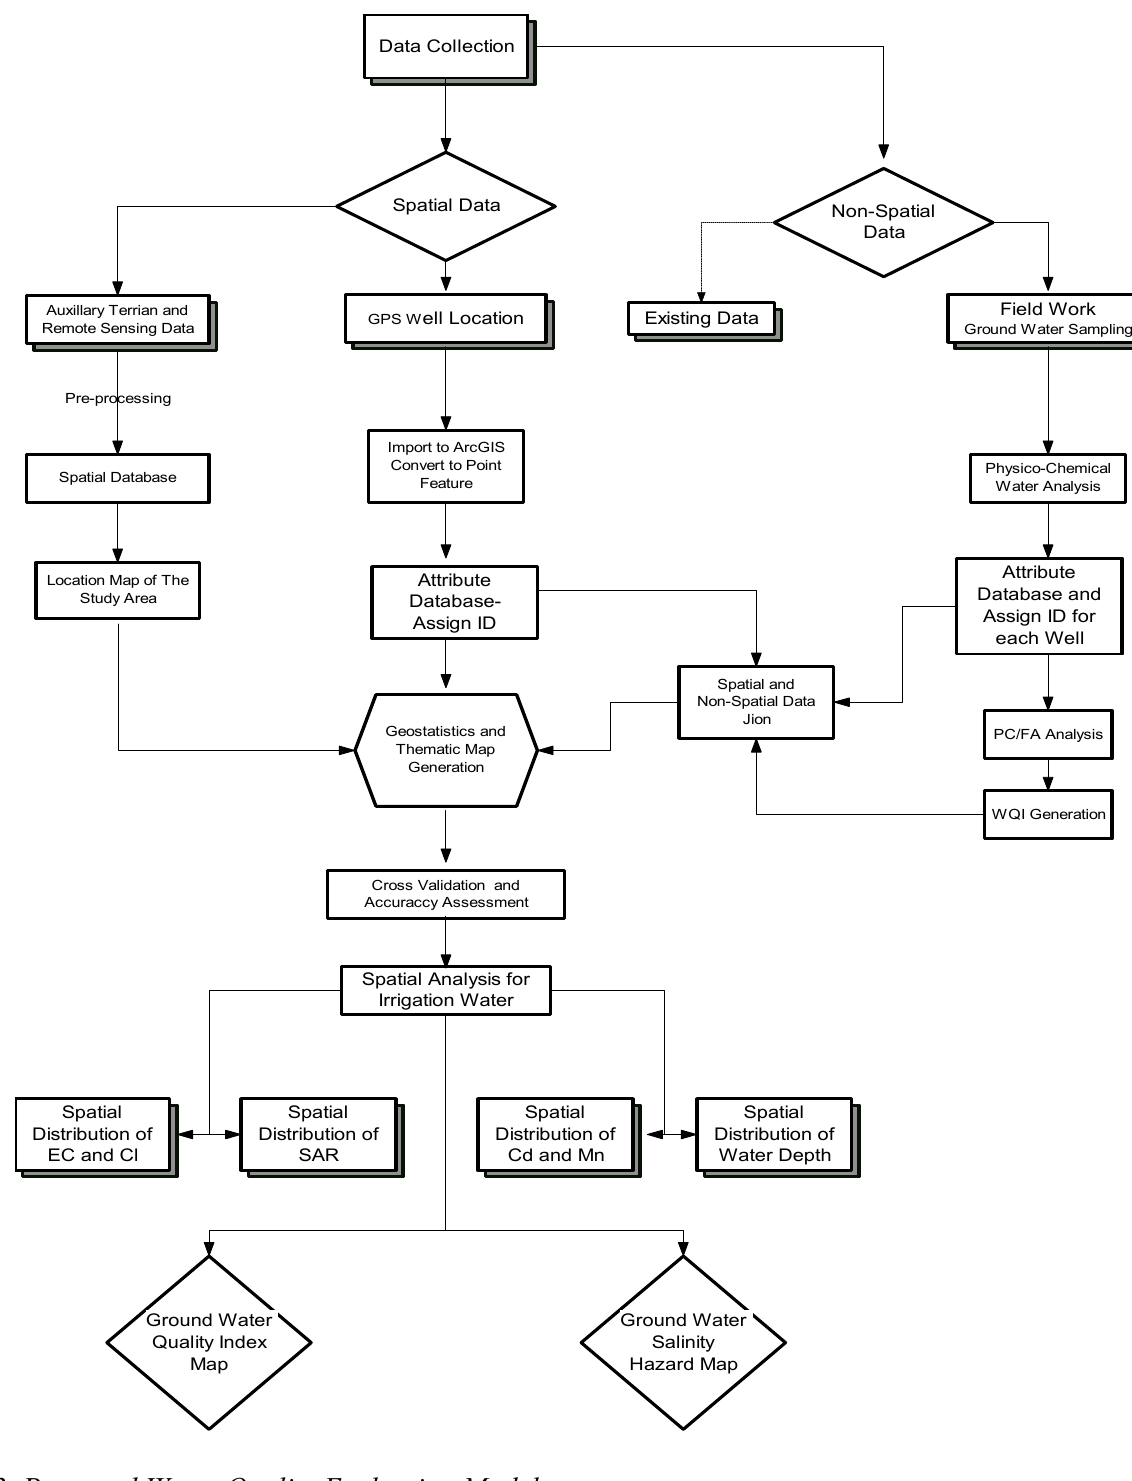
Figure 2. Flow chart showing the methodology adopted for groundwater quality